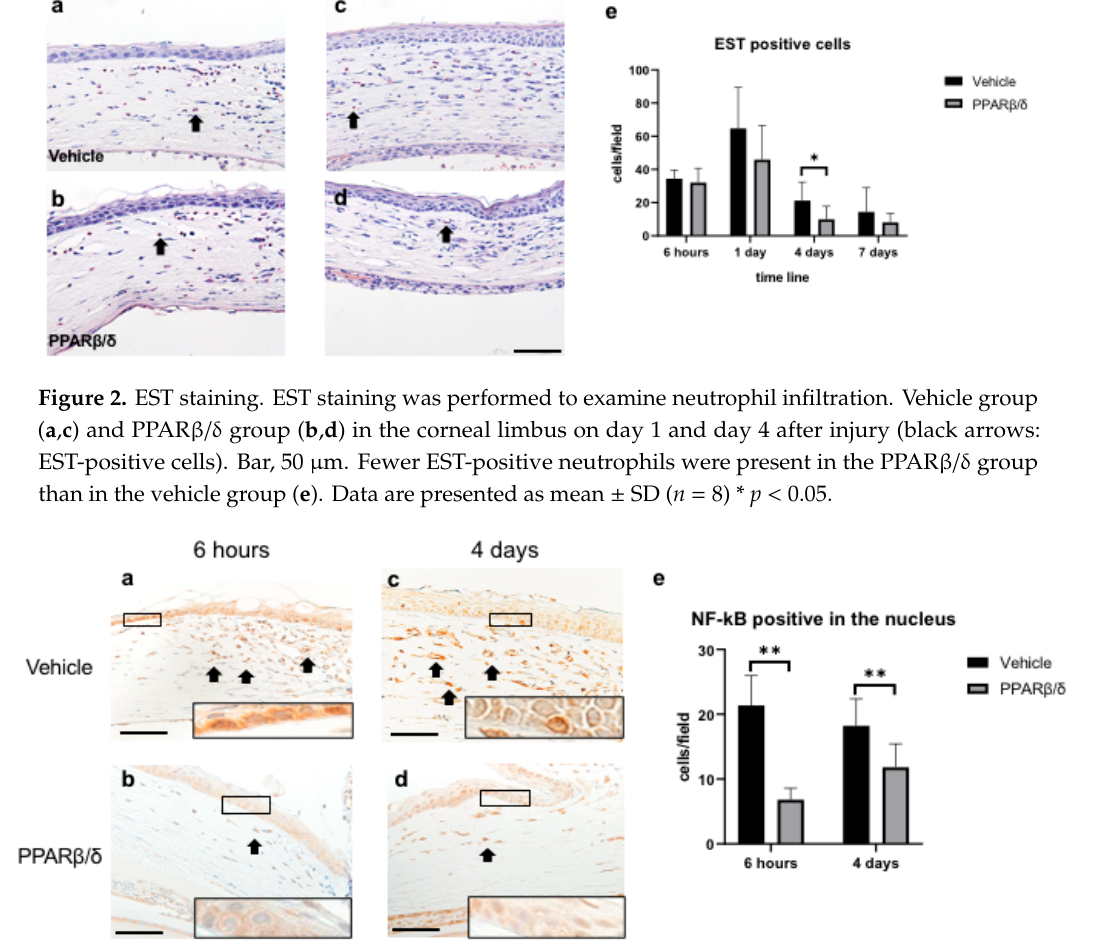
Figure 4. Immunohistochemical analysis of I- κ B α and quantitative evaluation determined by cell counting on the corneal periphery in each group. Representative sections at 6 h after injury are shown ( a , b ). PPAR β / δ group exhibited strong expression of I-kB α as compared to the vehicle group (see boxed area). Representative sections at day 4 after the injury are shown. I- κ B α expression was only found in the PPAR β / δ group ( c , d ). Higher magnification pictures of the boxed area are also shown. Bar, 50 μ m. There was a significantly higher number of I- κ B α -positive cells in the PPAR β group versus the vehicle group at each of the time points ( e ). Data are presented as mean ± SD ( 𝑛 = 8) ** p < 0.01.